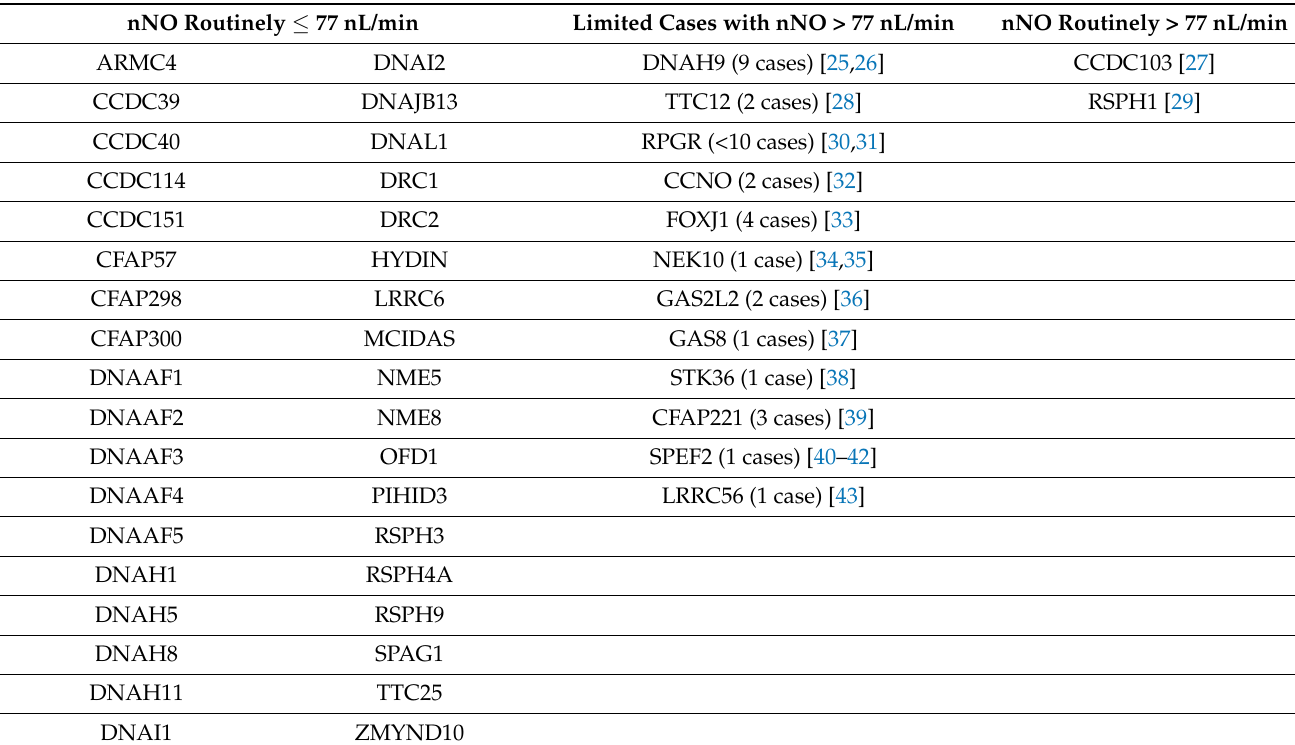
Table 1. PCD genotypes grouped by reported nasal nitric oxide (nNO) values. Reported case numbers of specific genes with nNO > 77nl/min are presented in